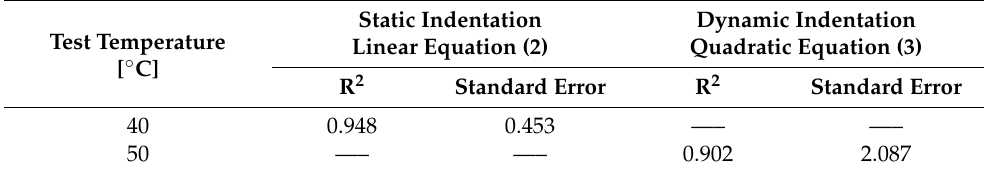
Table 5. Results of regression analysis for static and dynamic indentation tests.